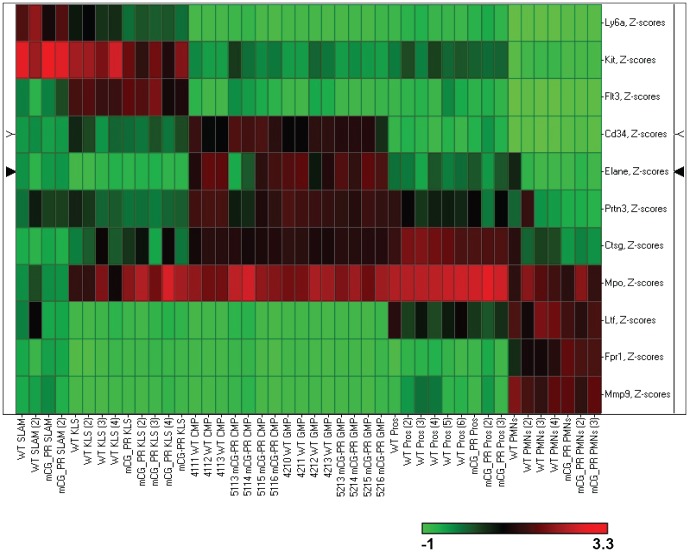
A supervised heatmap of 11 developmentally-regulated myeloid genes.Using the expression data from the Affymetirix Mouse Exon 1.0ST arrays, we created a supervised heatmap with SPOTFIRE using z-score averaging of the probeset with the highest average expression for each of 11 developmentally-regulated myeloid genes across all of our flow-sorted bone marrow cell samples. The legend is shown below the heatmap with downregulated genes in green and upregulated genes in red.